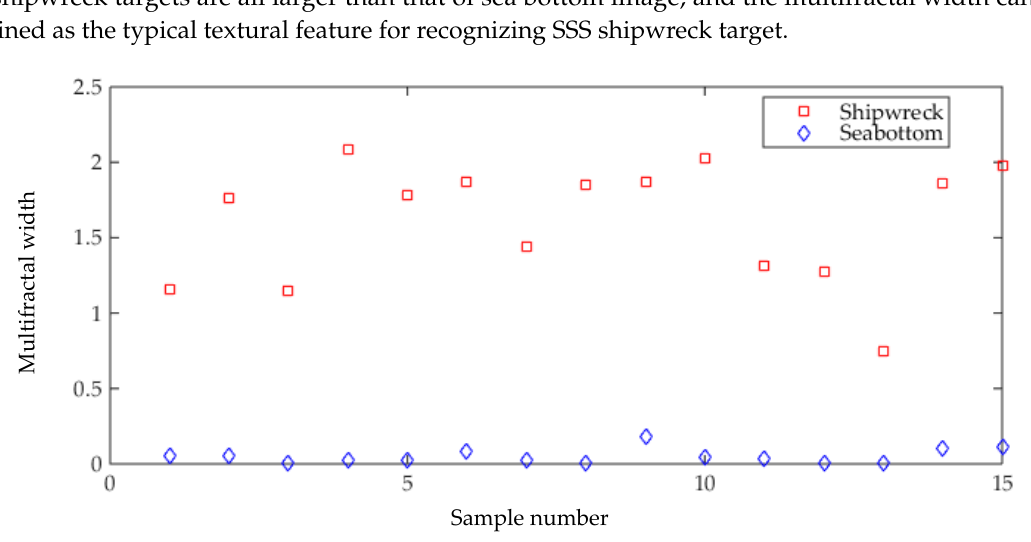
Figure 2. The value of multifractal width calculated by SSS images of shipwreck and sea bottom.